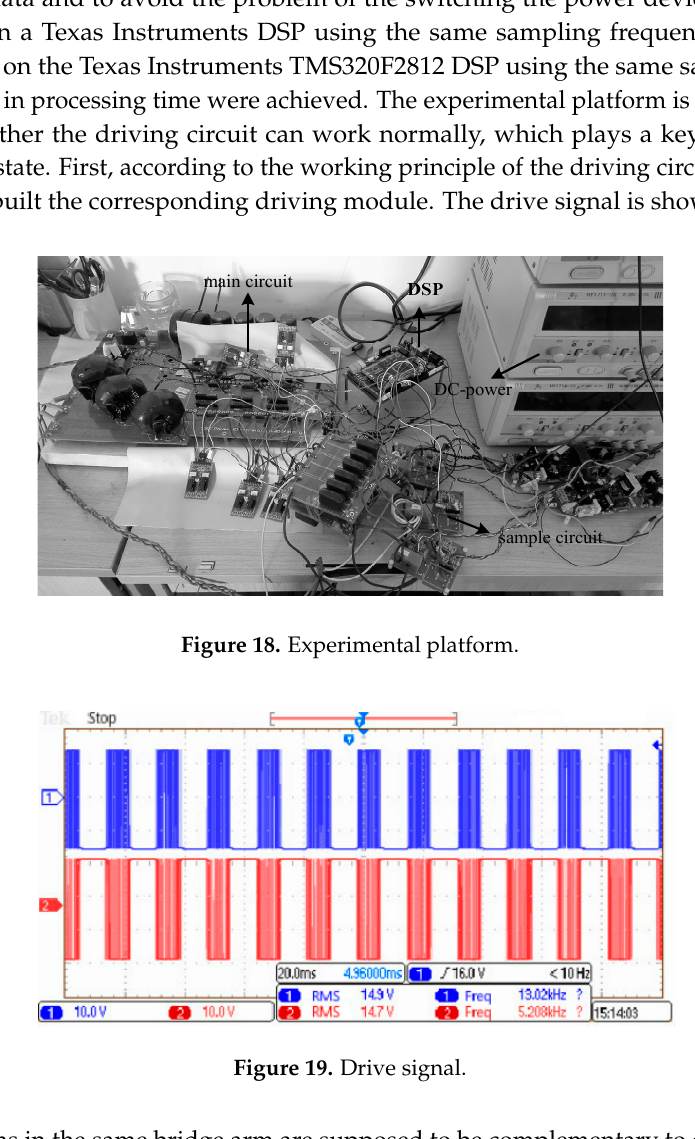
Figure 17. The influence of adjusting the weight factor of the capacitor voltage.